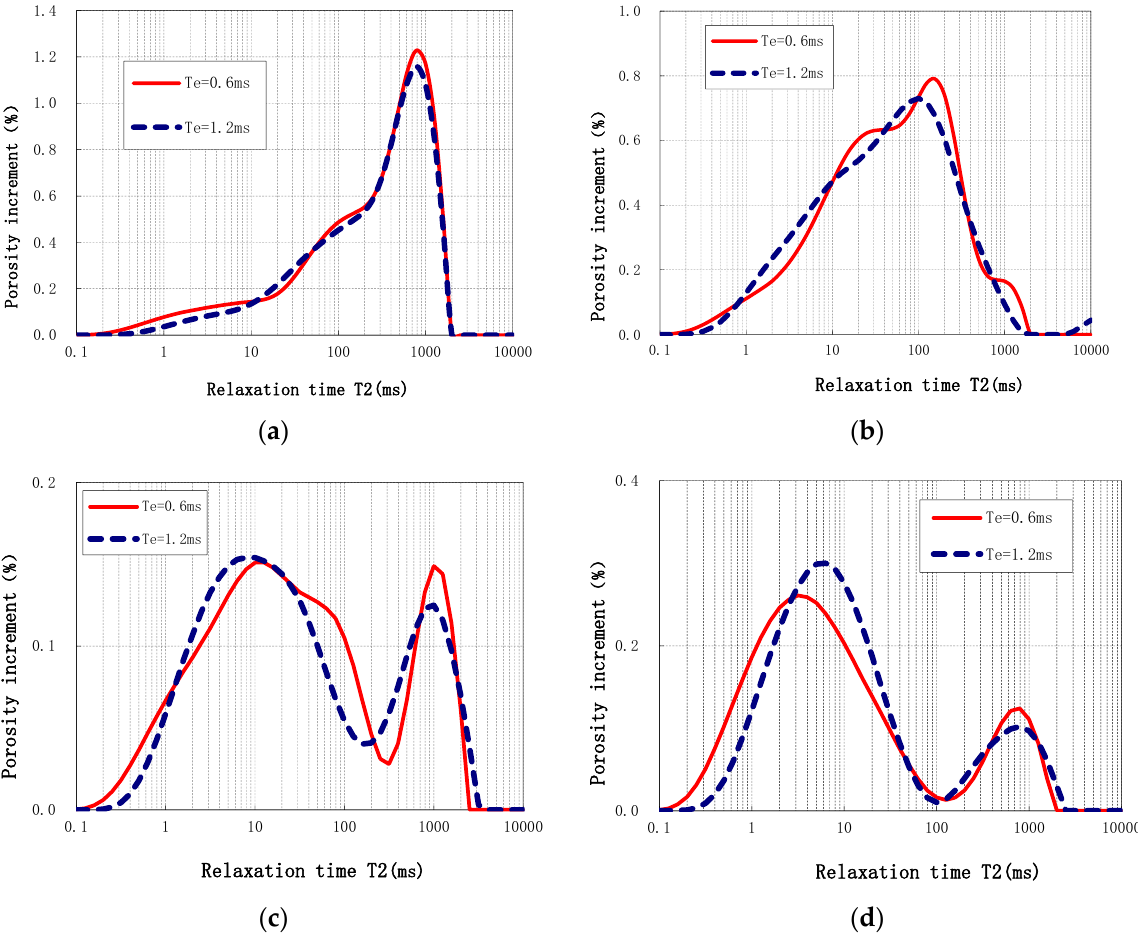
Figure 3. Typical reservoir NMR T2 spectrum characteristics. ( a ) NMR T2 Spectrum Characteristics of type I; ( b ) NMR T2 Spectrum Characteristics of type II; ( c ) NMR T2 Spectrum Characteristics of type III; ( d ) NMR T2 Spectrum Characteristics of type IV.